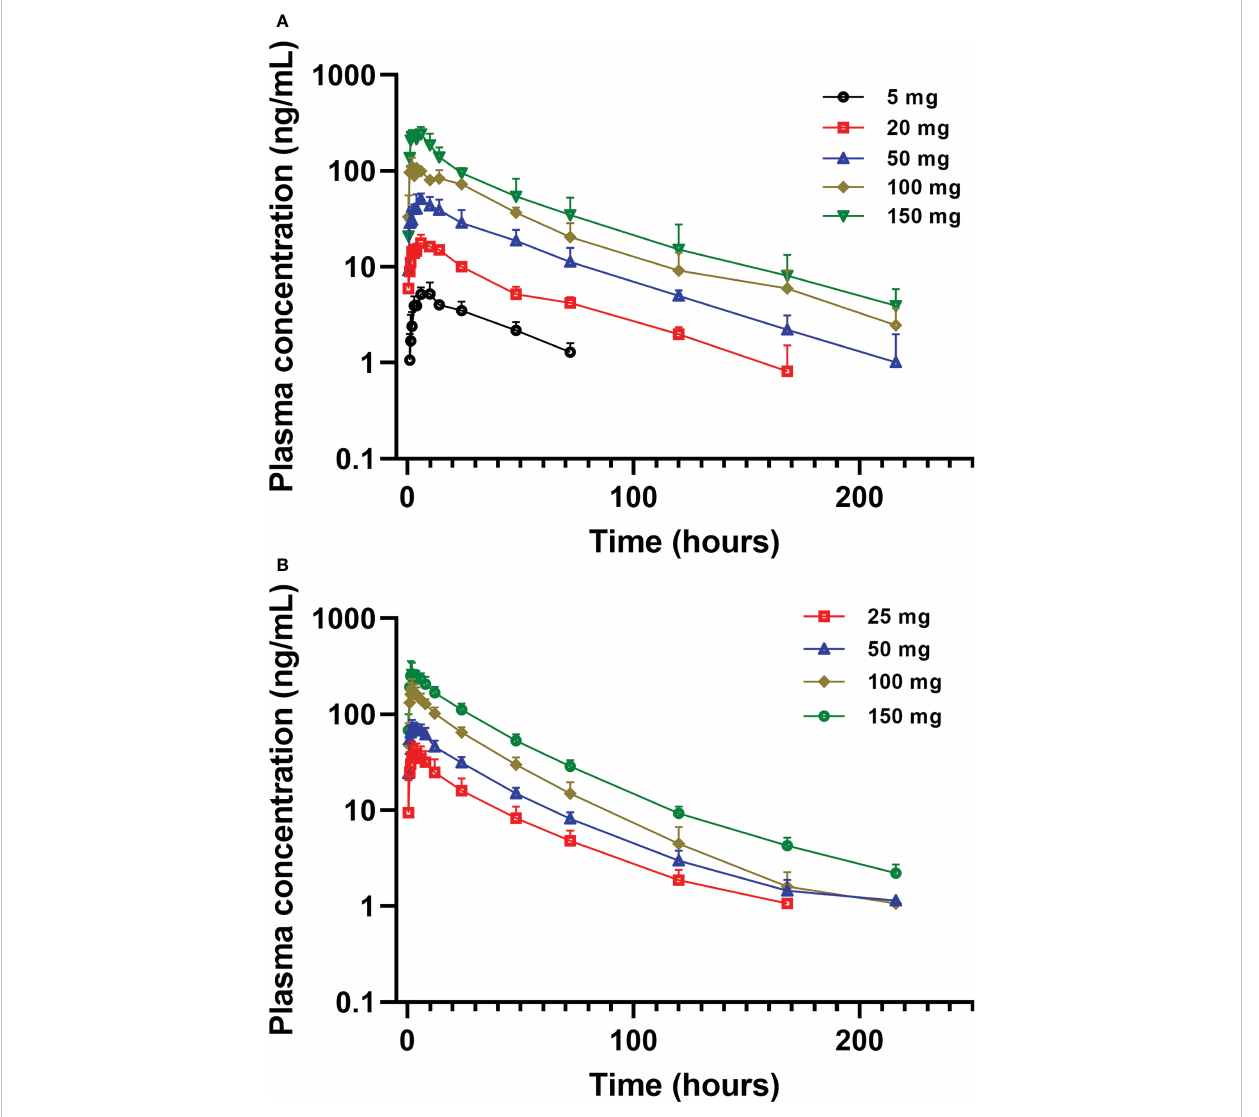
FIGURE 3 Mean (± SD) plasma concentration of golidocitinib following a single oral dose of golidocitinib: (A) subjects were dosed from 5 mg to 150 mg in JACKPOT2 study (n = 4 per dose level); (B) subjects were dosed from 25 mg to 150 mg in JACKPOT3 study (n = 6 per dose level). Blood samples were collected up to 216 hours post-dose for each